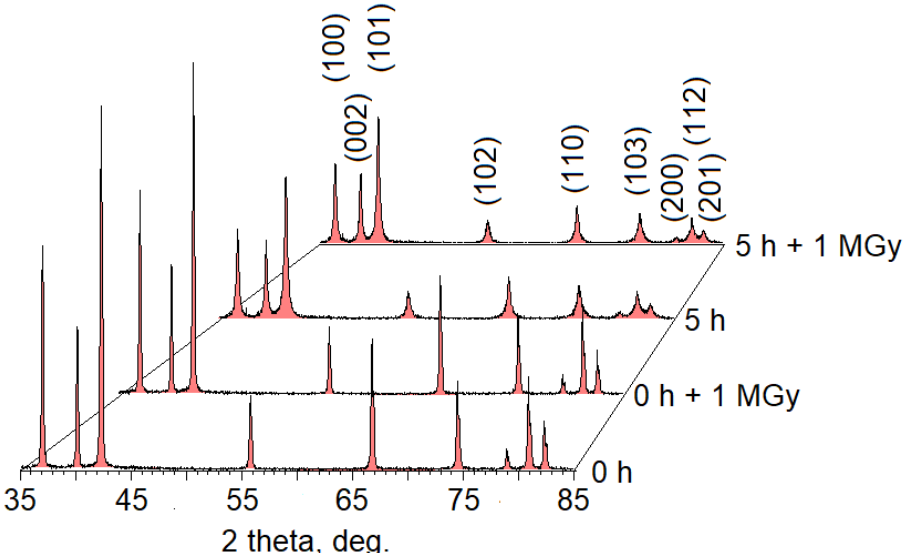
Figure 2. Diffraction patterns of the samples studied.